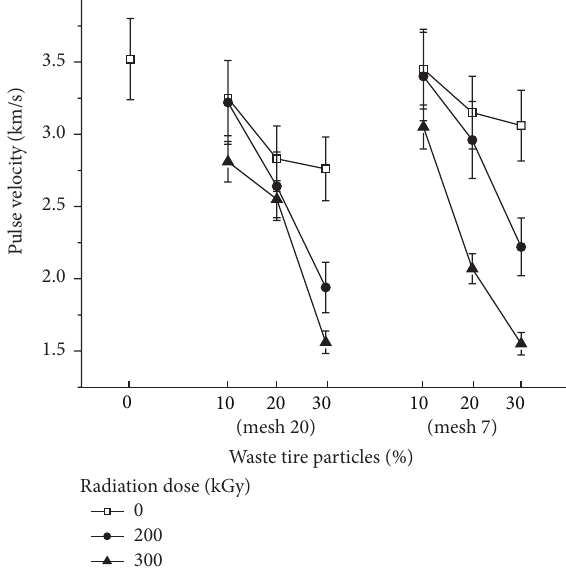
Figure 7: Pulse velocity of concrete with waste tire particles of 0.85 mm and 2.8